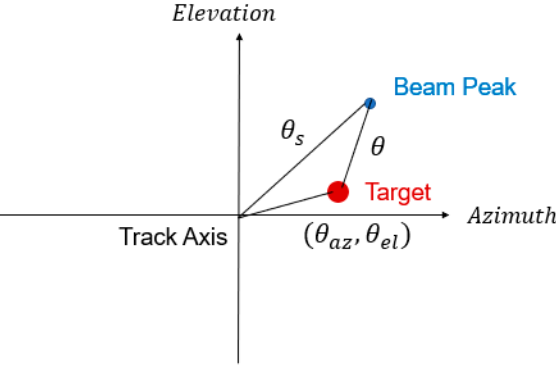
Figure 2. Target location in the track axis.